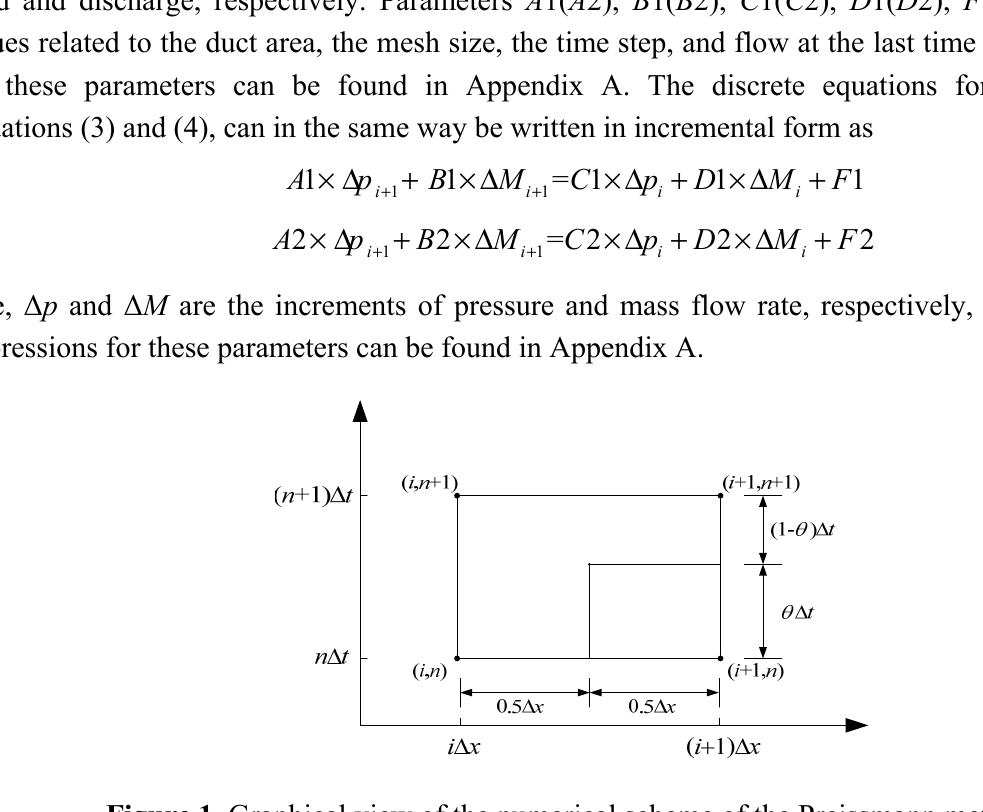
Figure 1. Graphical view of the numerical scheme of the Preissmann